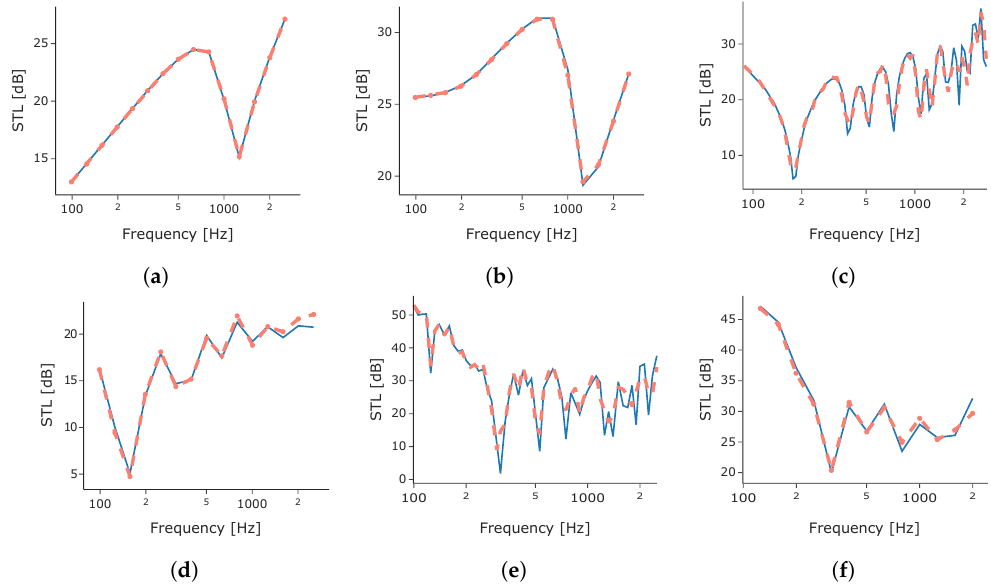
Figure 14. Example of one predicted STL curve for each STL model using the neural network (NN)-based surrogate with physics-guided features: simulated; predicted; ( a ) infinite plate; ( b ) correction factor; ( c ) MS; ( d ) MS (band averaged); ( e ) FEM; ( f ) FEM (band averaged).